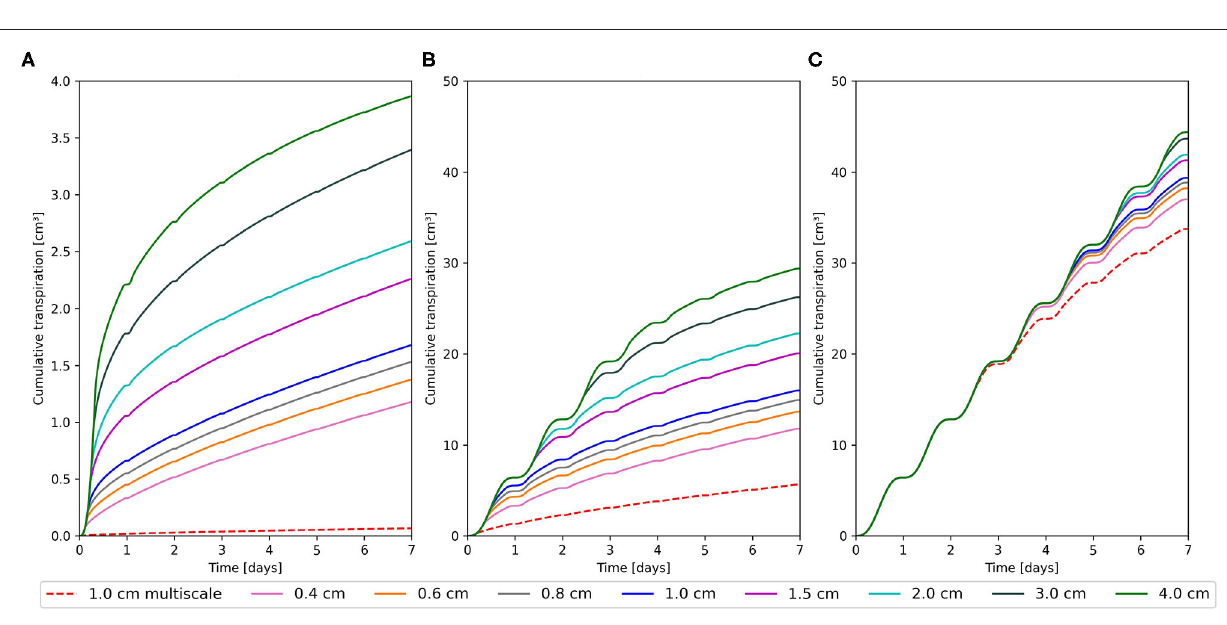
solution is covered by small edge-lengths in the multi-scale model ( Supplementary Figure S2 ). Conceptually, as the multi-scale model assumes equal distribution of root segments within